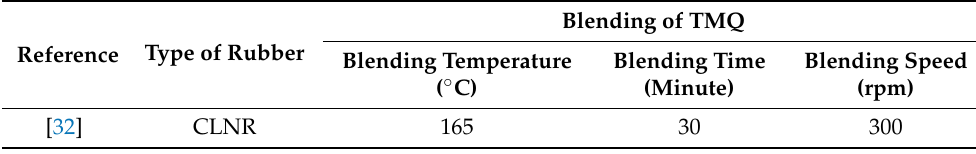
Table 11. Method of TMQ application based on previous studies.